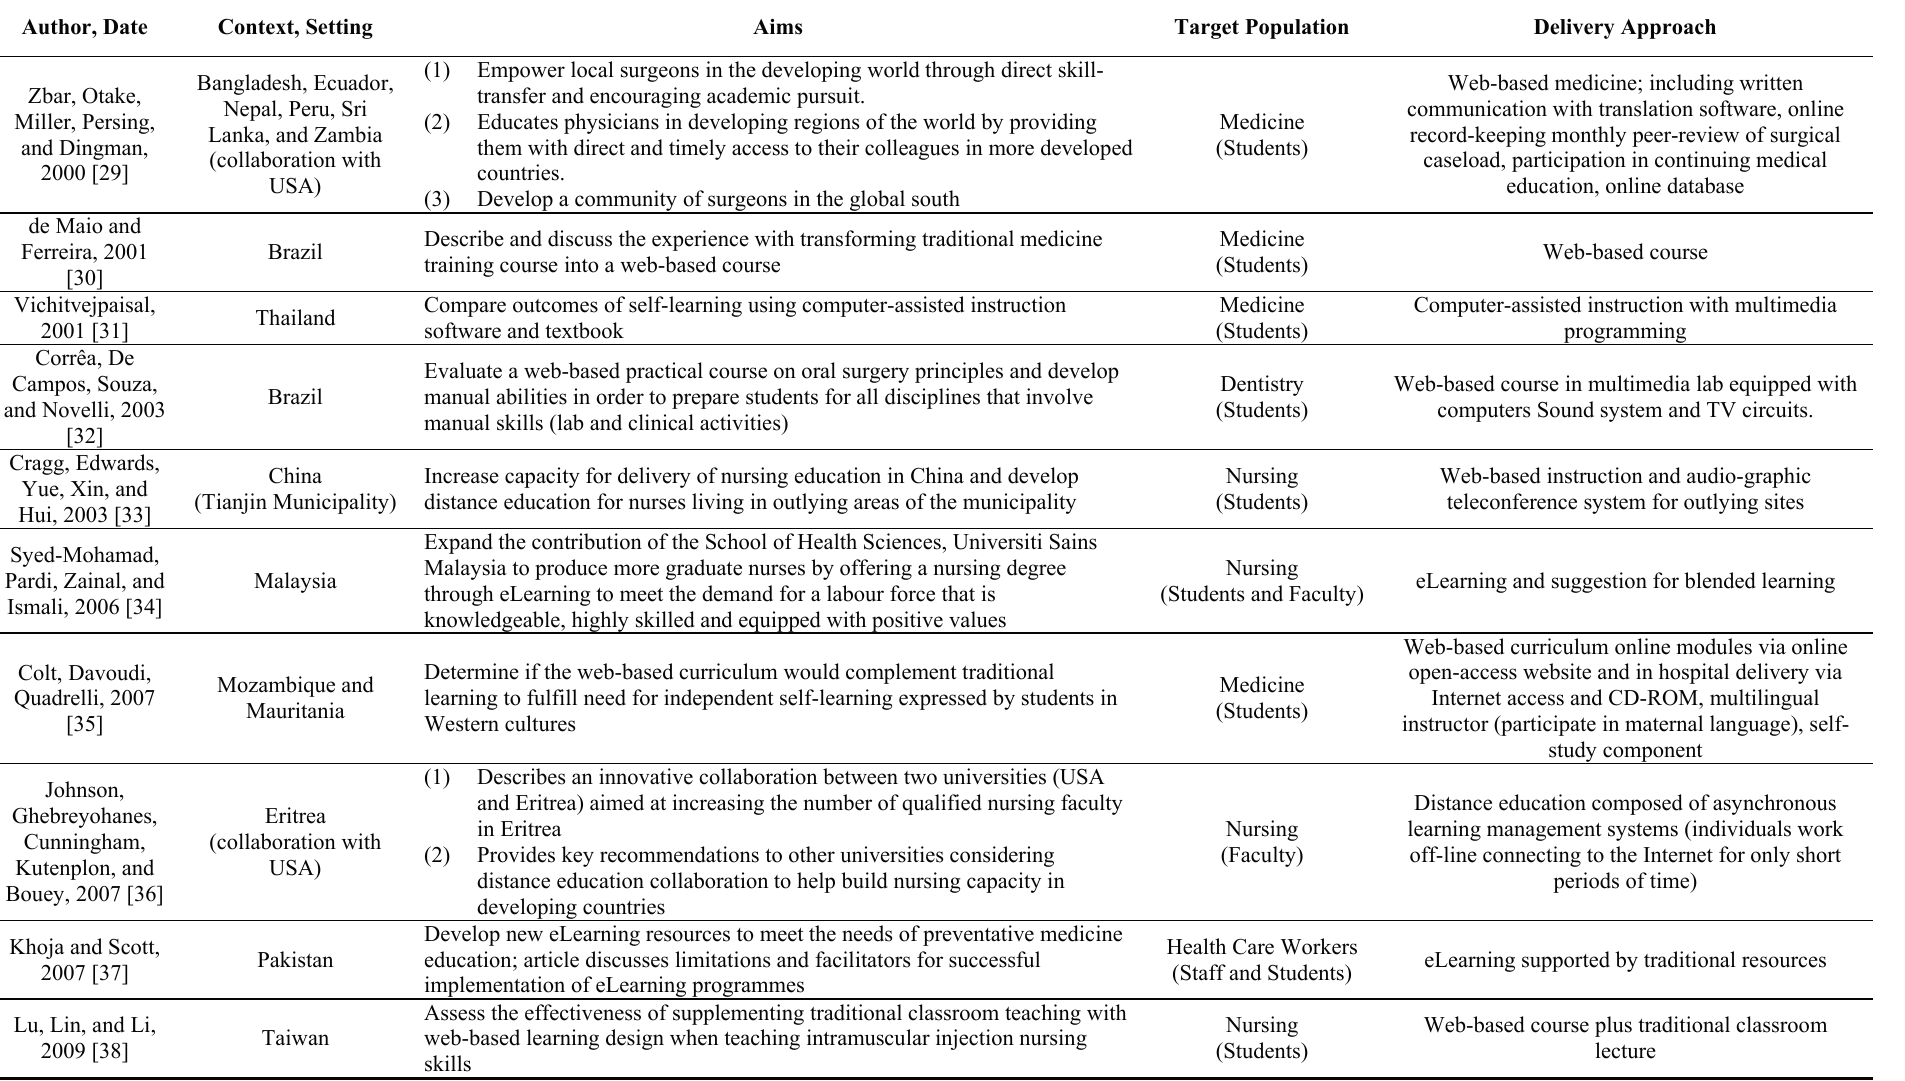
Table 2. Summary of findings from 30 peer-reviewed empirical studies of eLearning in developing